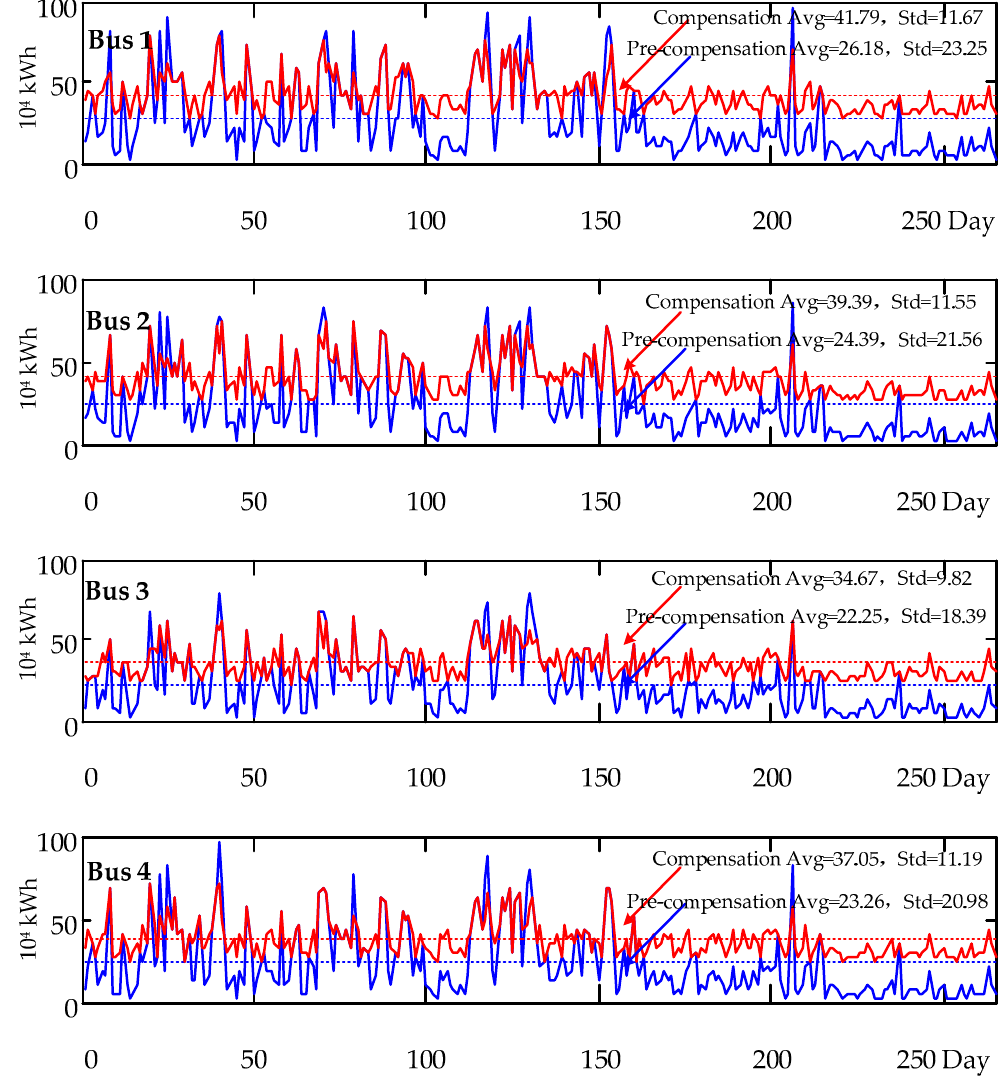
Figure 16. P R > 3Avg ( P R ) battery charging, P R < Avg ( P R ) battery discharging.